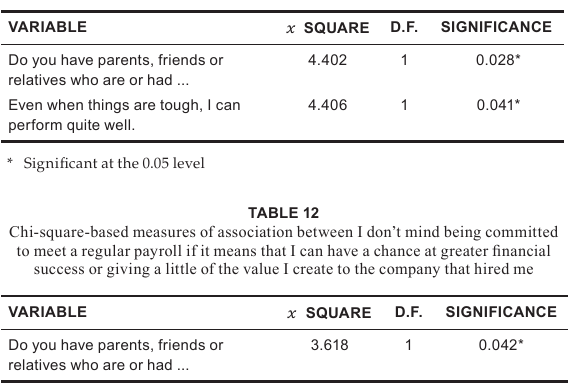
table 11 Chi-square-based measure of association between new venture success follows a particular script or depends heavily on the pluses and minuses in a given situation